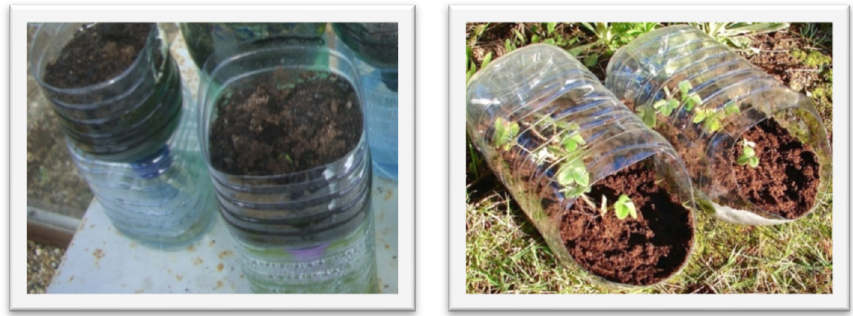
Figure 6. Pictures of transporting the students’ plants in their eco-art project.